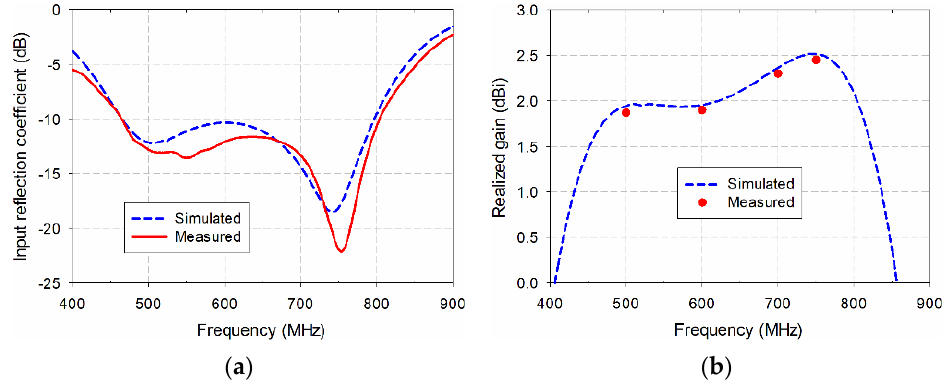
Figure 10. The proposed antenna fabricated on an FR4 substrate.